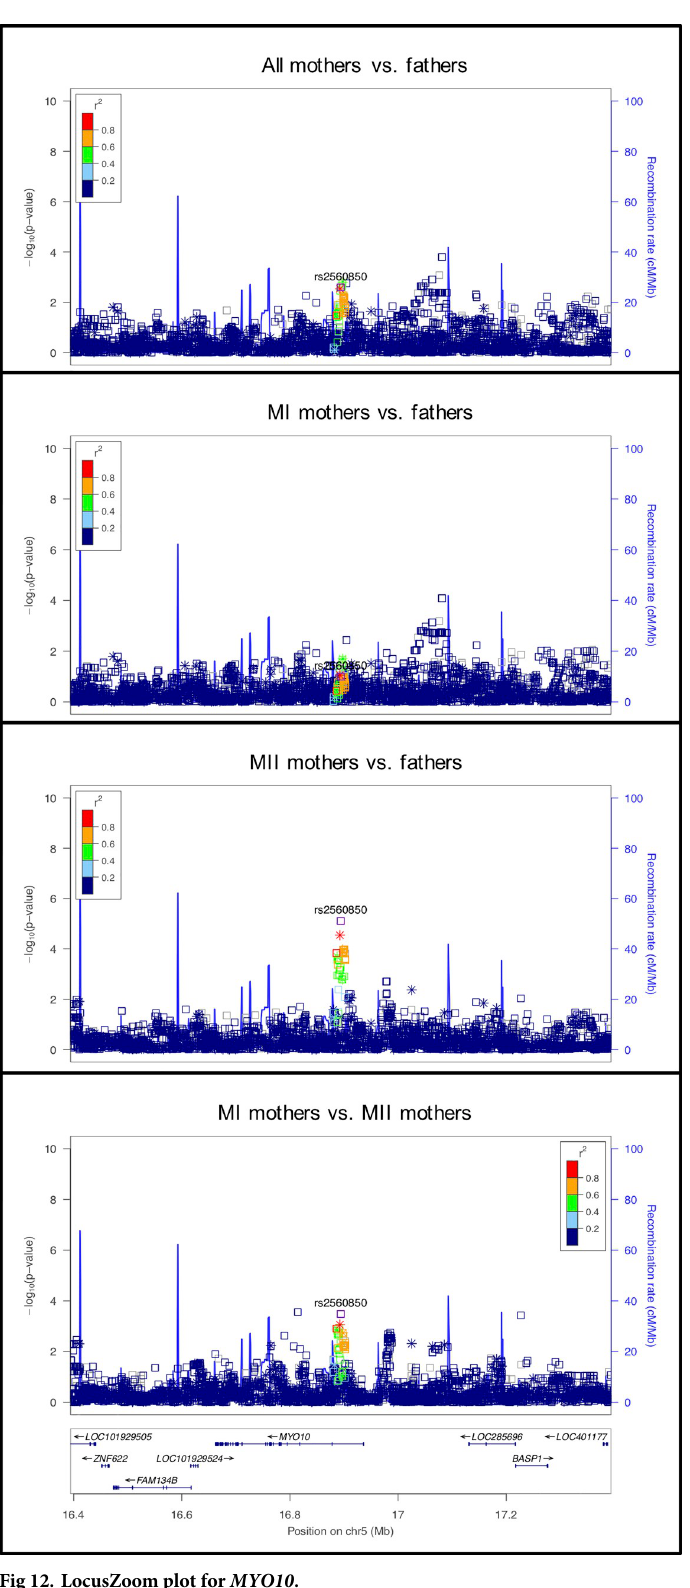
Fig 12. LocusZoom plot for MYO10